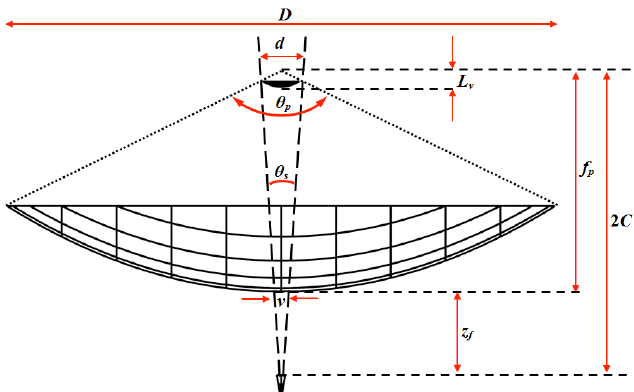
Figure 2: Optical arrangement of an on-axis Cassegrain antenna.